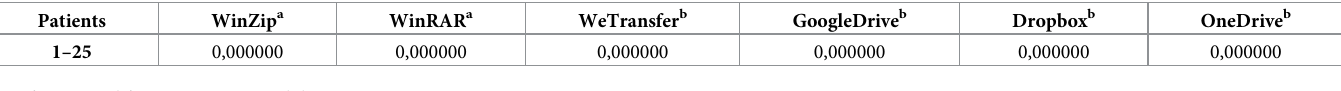
Table 1. Values of difference in structural dimensions in the different groups according to compression software and online transmission tool used in the mixed dentition scanning models. Patients